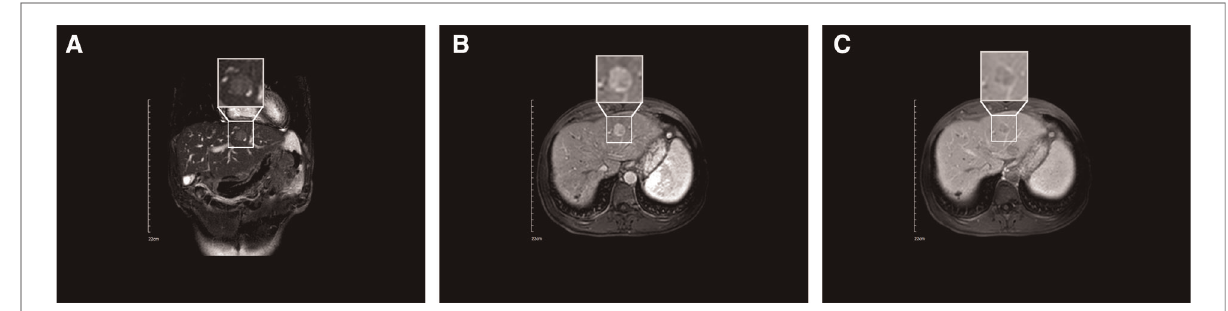
FIGURE 3 Results of MRI conducted on 11 January 2021. ( A ) Coronal MRI depicting a low-signal nodule in the left lobe of the liver. ( B ) Enhanced MRI depicting a high-signal nodule in the left lobe of the liver at the artery stage. ( C ) Enhanced MRI indicating fast enhancement regression of the nodule in the left lobe of the liver at the vein